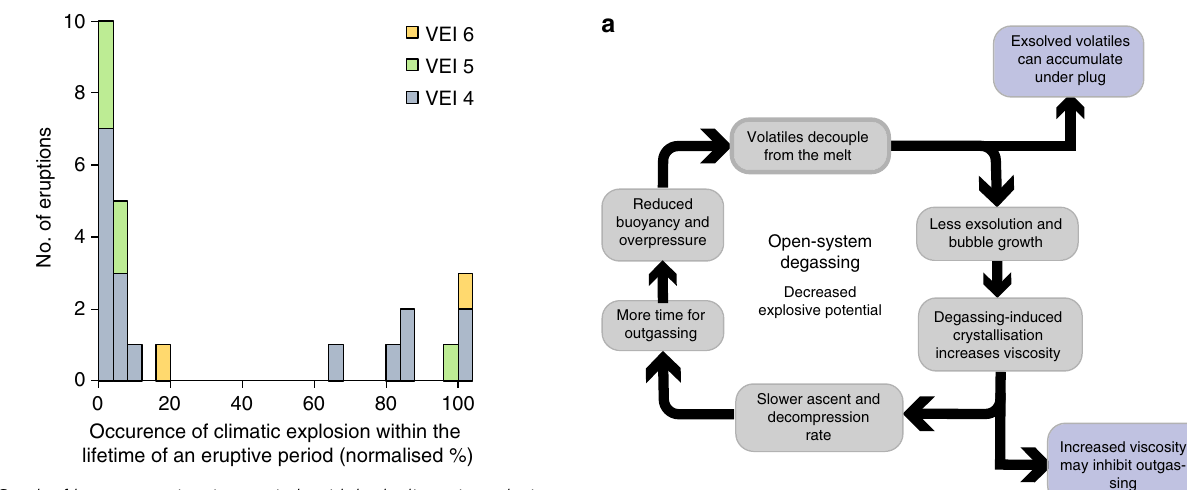
time for outgas- sing may lead to disequilibrium degassing